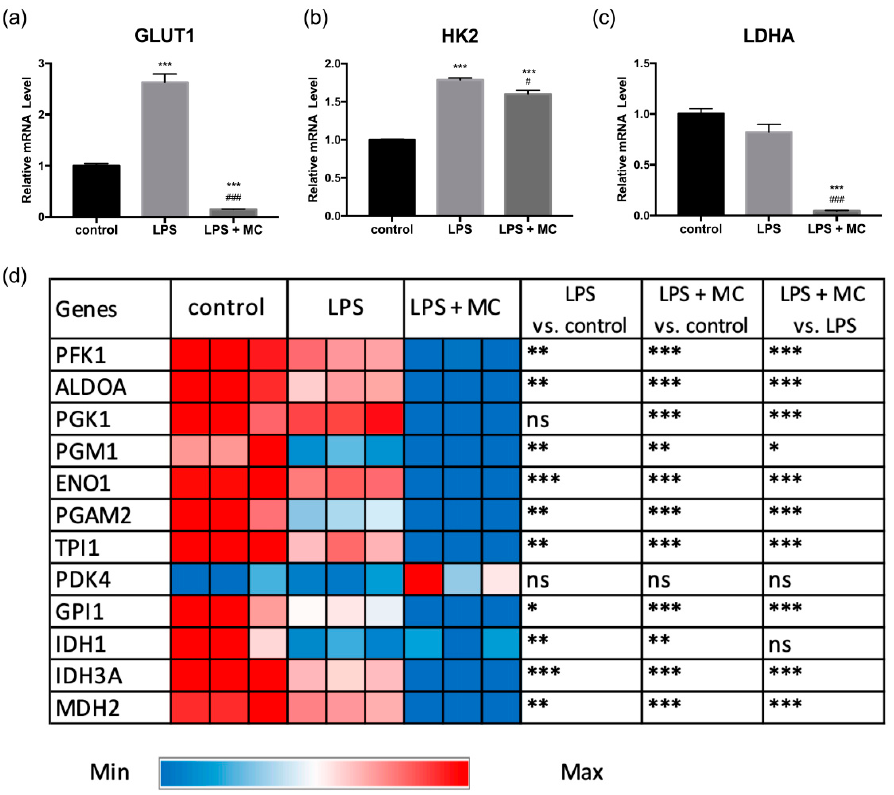
# p < 0.05, ### p < 0.001 compared with the LPS group. For ( d ), * p < 0.05, ** p < 0.01, *** p < 0.001; ns, no significant di ff erence between